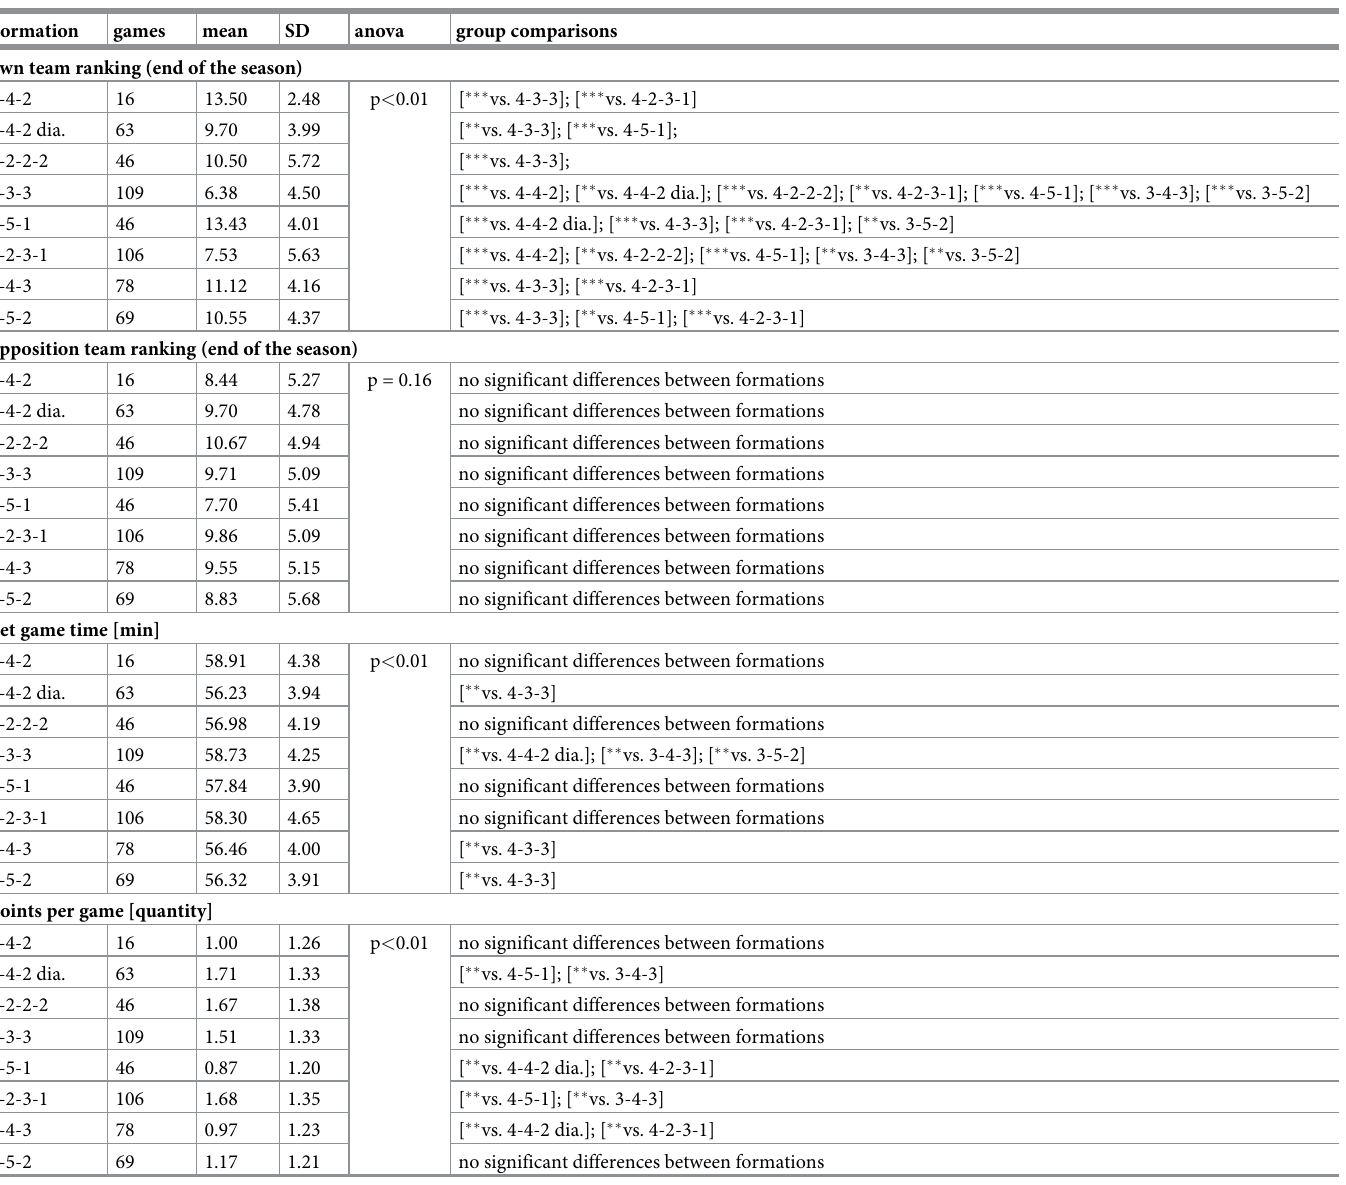
Fig 5. Forward. Data of forwards are presented as mean values ± SD. Anova revealed p < 0.05 for each parameter except high-intensity distance (p = 0.80). Black parentheses indicate significant differences (p < 0.05) between the formations. Each significant group difference is labelled with S for small, M for medium or L for large effect size.